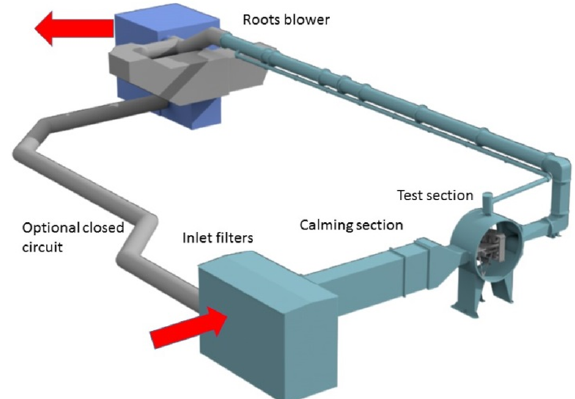
Figure 1. UWB test-rig, wind tunnel.